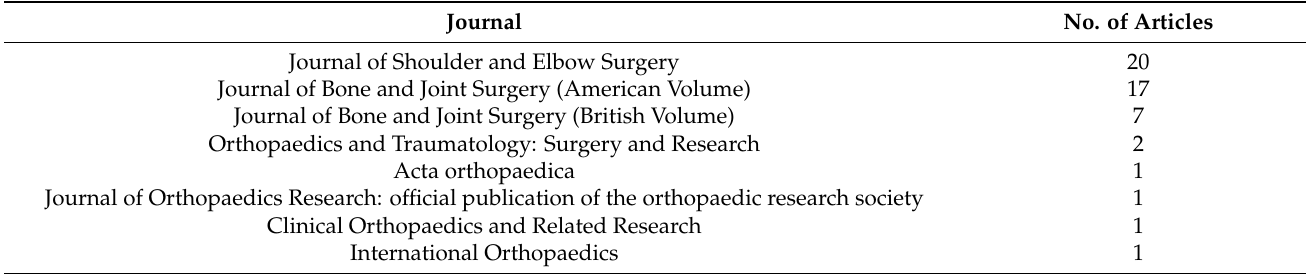
Table 3. Number of citations on top 50 list by source